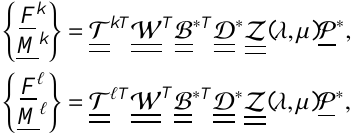
(solid line), κ ∗ 1 2 Figure 12. Components of the wryness vector: κ ∗ (dashed line), κ ∗ (dash-dotted line). Case 3a ( (cid:13) ), 3b ( 4 ), 3c ( 5 ), 3 3d ( ∗